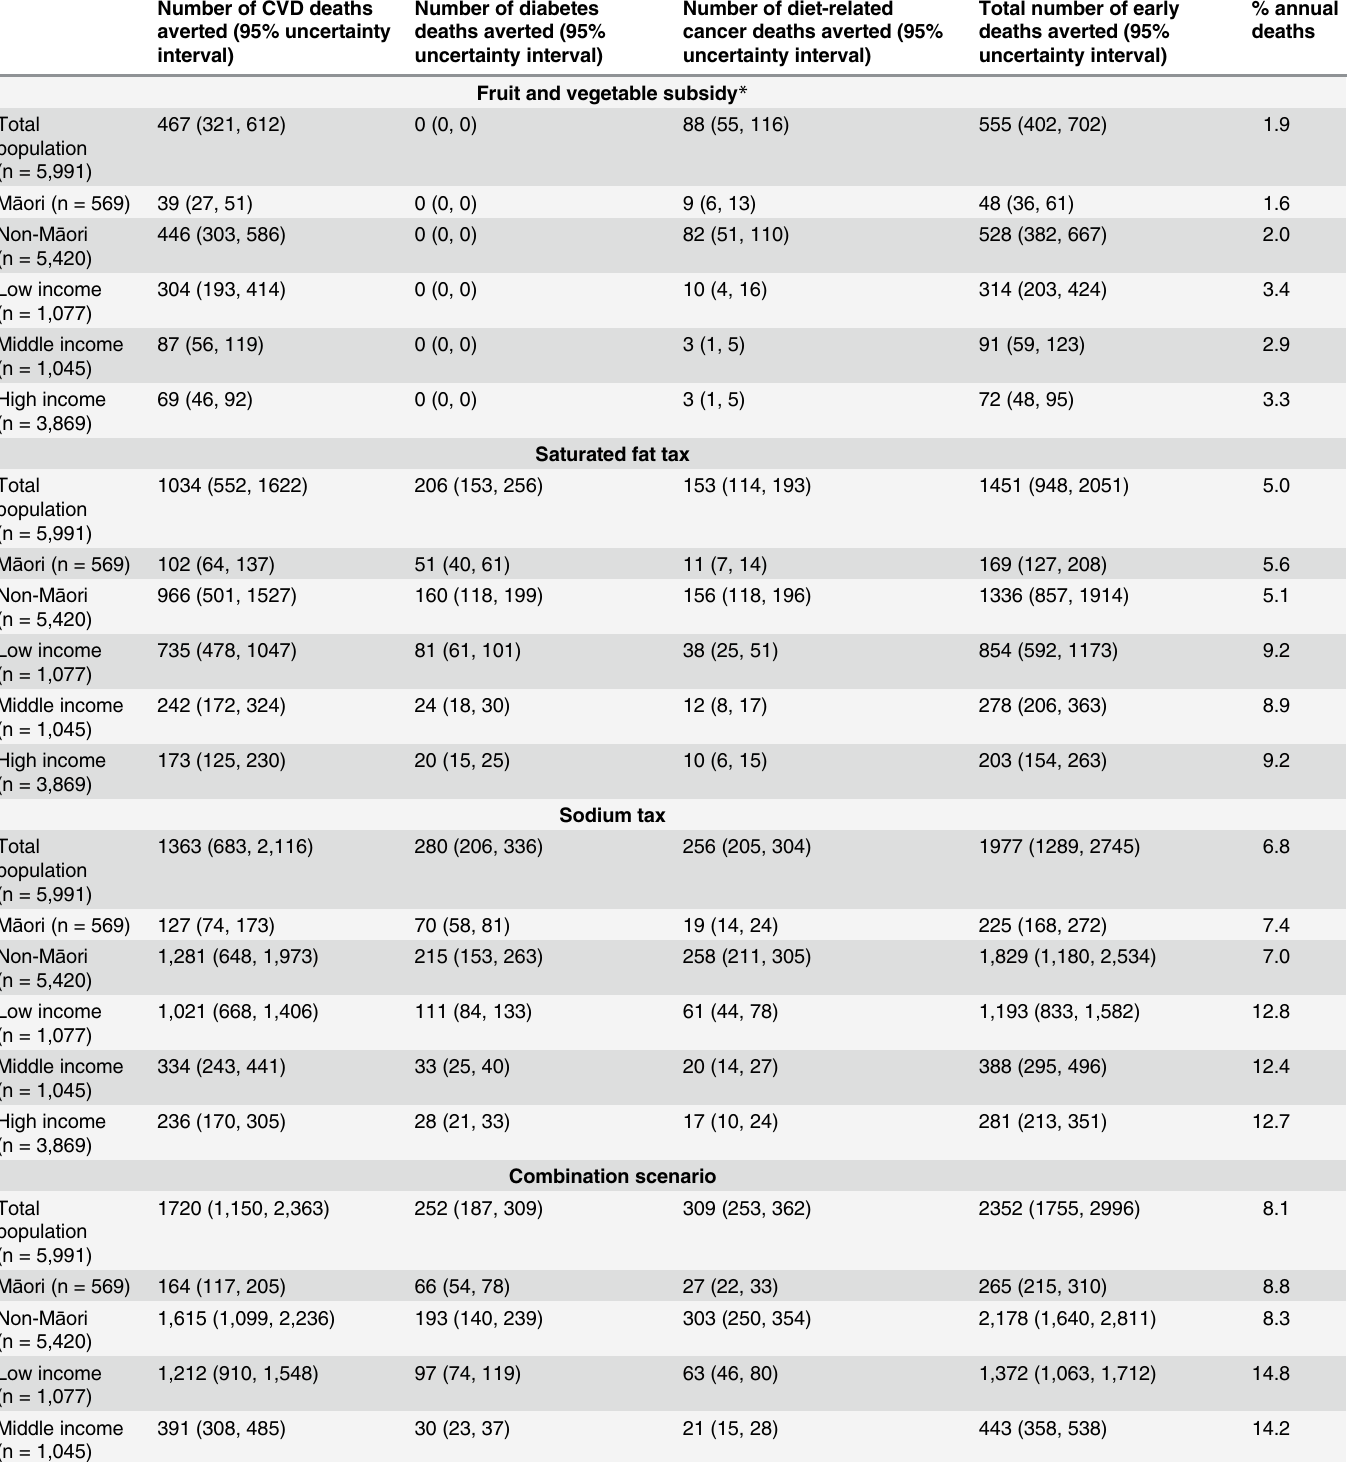
Table 4. Changes in mortality from diet-related diseases, overall and by ethnicity and